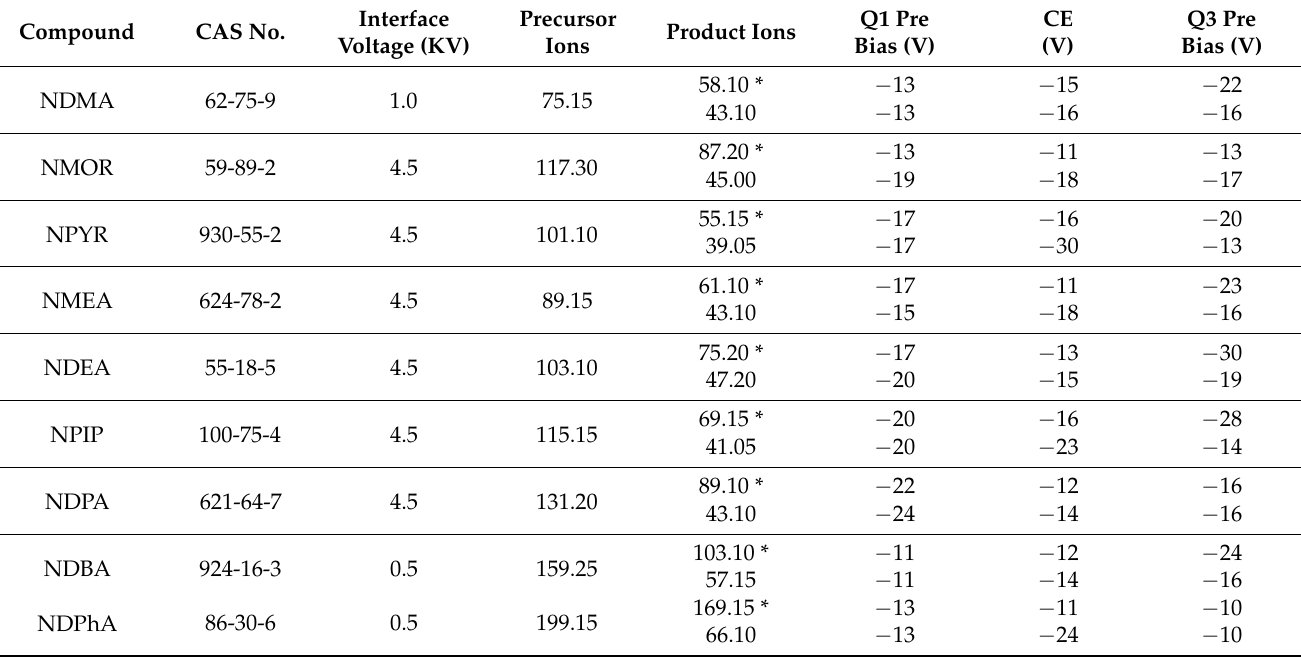
Table 3. Mass spectrometric parameters of